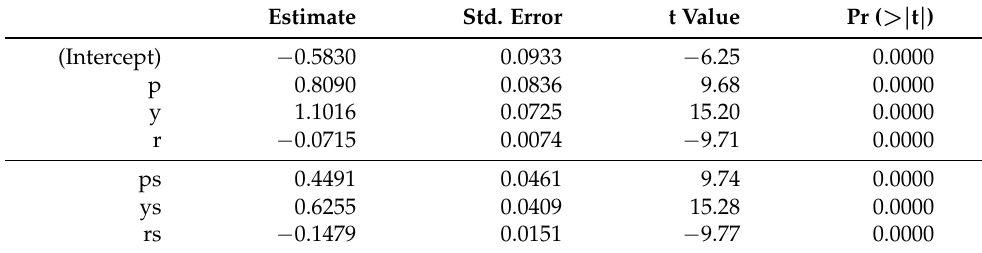
Table 2. OLS Results for Macro Example: money supply (m) regressed on prices, income, and interest rates. Denoting standardized regressors with the ‘s’ suffix and forcing a zero intercept, lower panel ‘estimates’ suggest practical significance in a linear